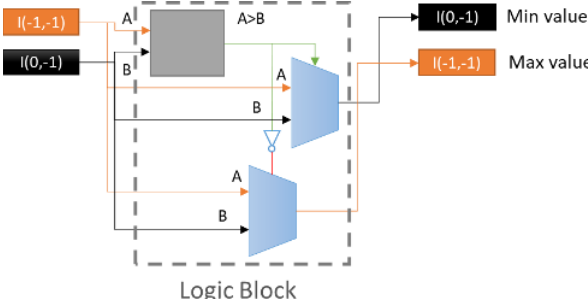
Fig. 7. Logic Block structure